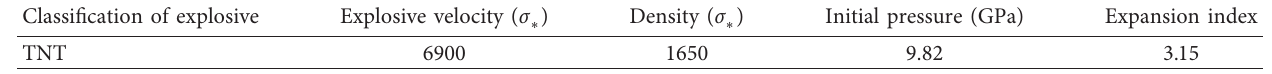
Table 1: Characteristic parameters of TNT.